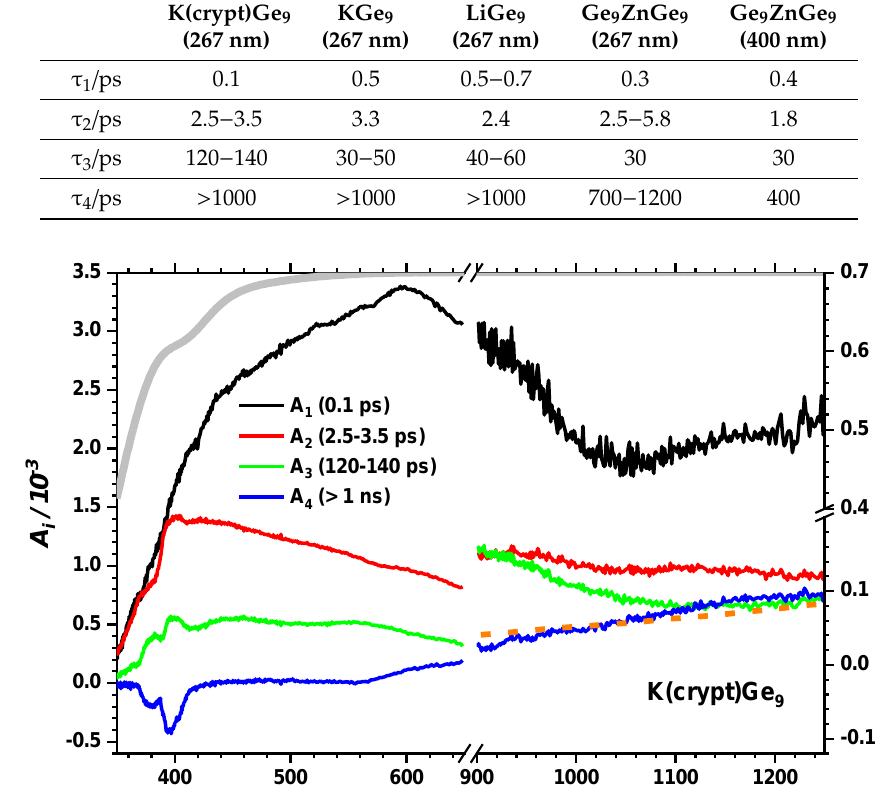
Table 1. Time constants from global analysis after UV (267 nm) and additionally 400 nm excitation for Ge 9 ZnGe 9 .